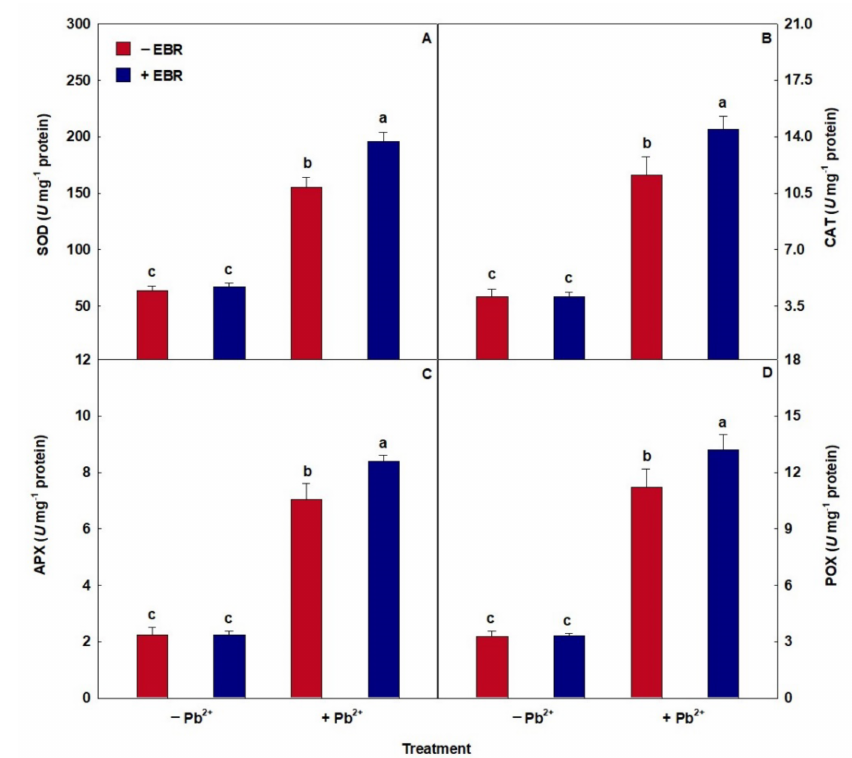
Figure 2. ( A ) Activities of superoxide dismutase (SOD), ( B ) catalase (CAT), ( C ) ascorbate peroxidase (APX), and ( D ) peroxidase (POX) in tomato plants treated with 24-epibrassinolide (EBR) and subjected to lead (Pb) toxicity. Columns with different letters indicate significant differences from the Scott– Knott test ( p < 0.05). Means ± SD, n =